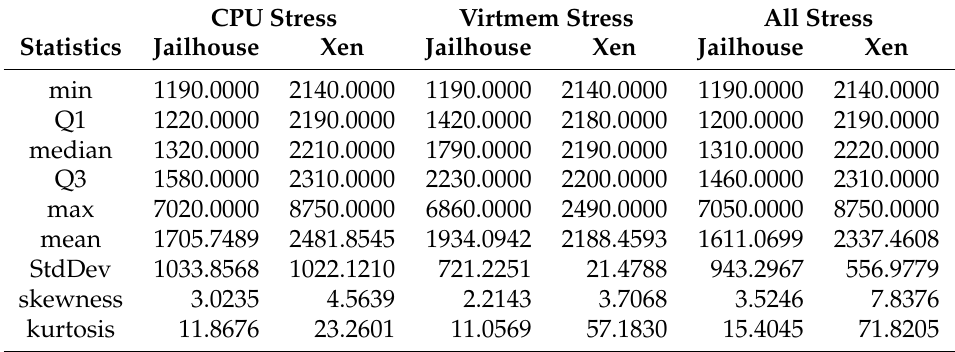
Table 2. Statistical results in the time to service interrupt (ns) for all 700 interrupt